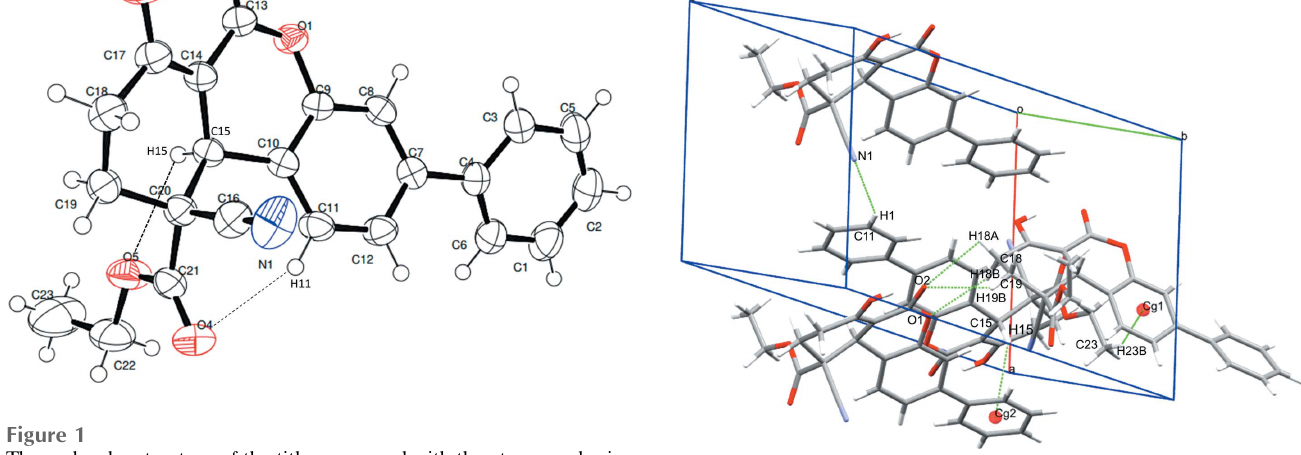
Figure 2 Intermolecular interactions in the title compound.